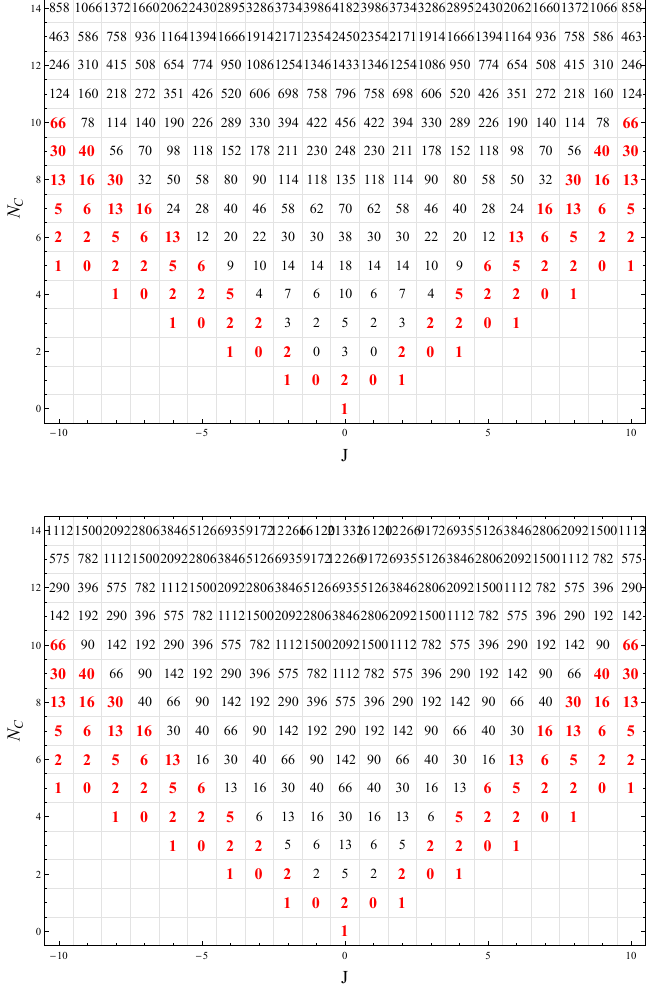
Figure 3 . Multiplicities of states with angular momentum J and level N c for the ASA spectrum (the top panel) and for effective closed strings (the bottom panel). Red entries are the same for both